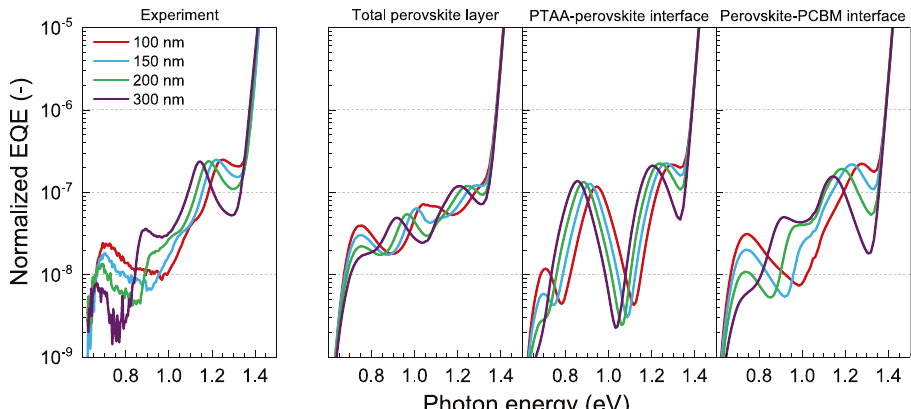
Fig. 4 Experimental and modeled EQE spectra of perovskite solar cells with a transparent back contact and a spacer mirror on top. The simulated EQEs result from two defect functions (Eq. (2)) at photon energies E d = 0.72 and E d = 1.09 eV, with σ d = 0.04 eV, multiplied by | E | 2 after averaging over the entire perovskite layer, or over a half-normal distribution with a standard deviation of 30 nm, centered at the PTAA – perovskite or at the perovskite – PCBM interface. An Urbach tail has been added to enable comparison with the experimental data. The legend gives the thickness of the MgF 2 optical spacer positioned between the transparent ITO back electrode and the Ag mirror (see Fig.